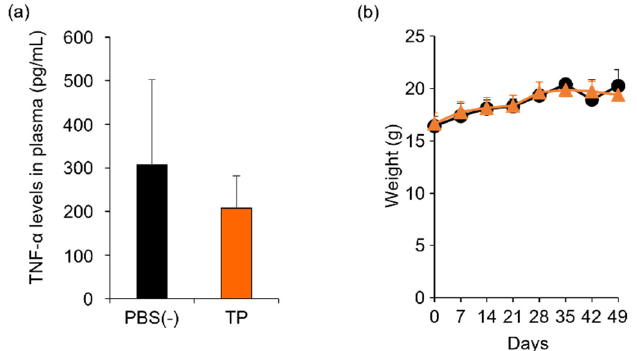
Figure 7. Comparison of plasma TNF- α levels and body weight between control and TP-administered mice. PBS ( − ) (black) and TP dissolved in PBS ( − ) (orange) were intraperitoneally administered into mice thrice weekly, 7 days after laminarin injection. ( a ) Plasma TNF- α levels at 26 days after laminarin injection. ( b ) Body weight. N = 3, Bars represent standard deviation (SD).